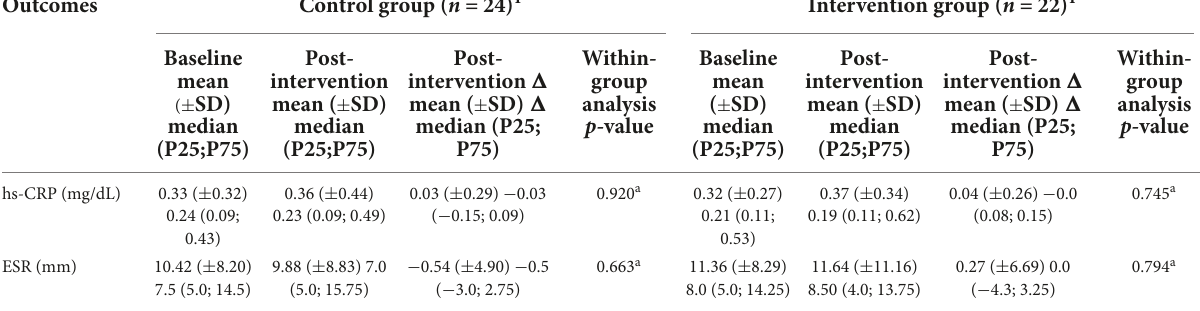
TABLE 6 Biochemical parameters assessment in control and intervention group at baseline and post-intervention.